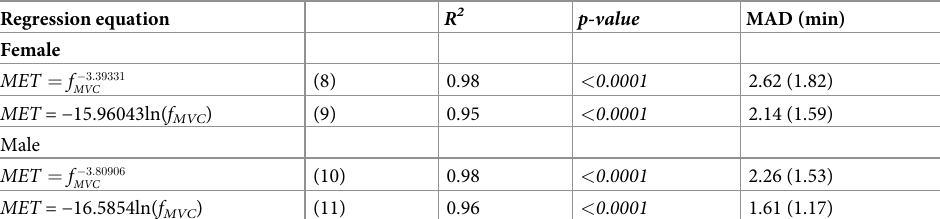
Table 4. MET predictive models.